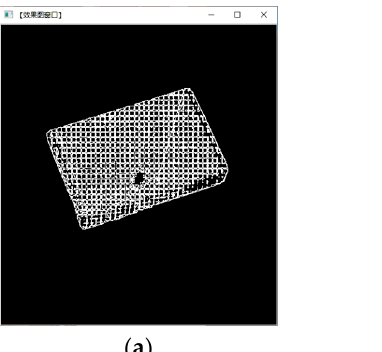
Table 1. Different types of parking spaces.